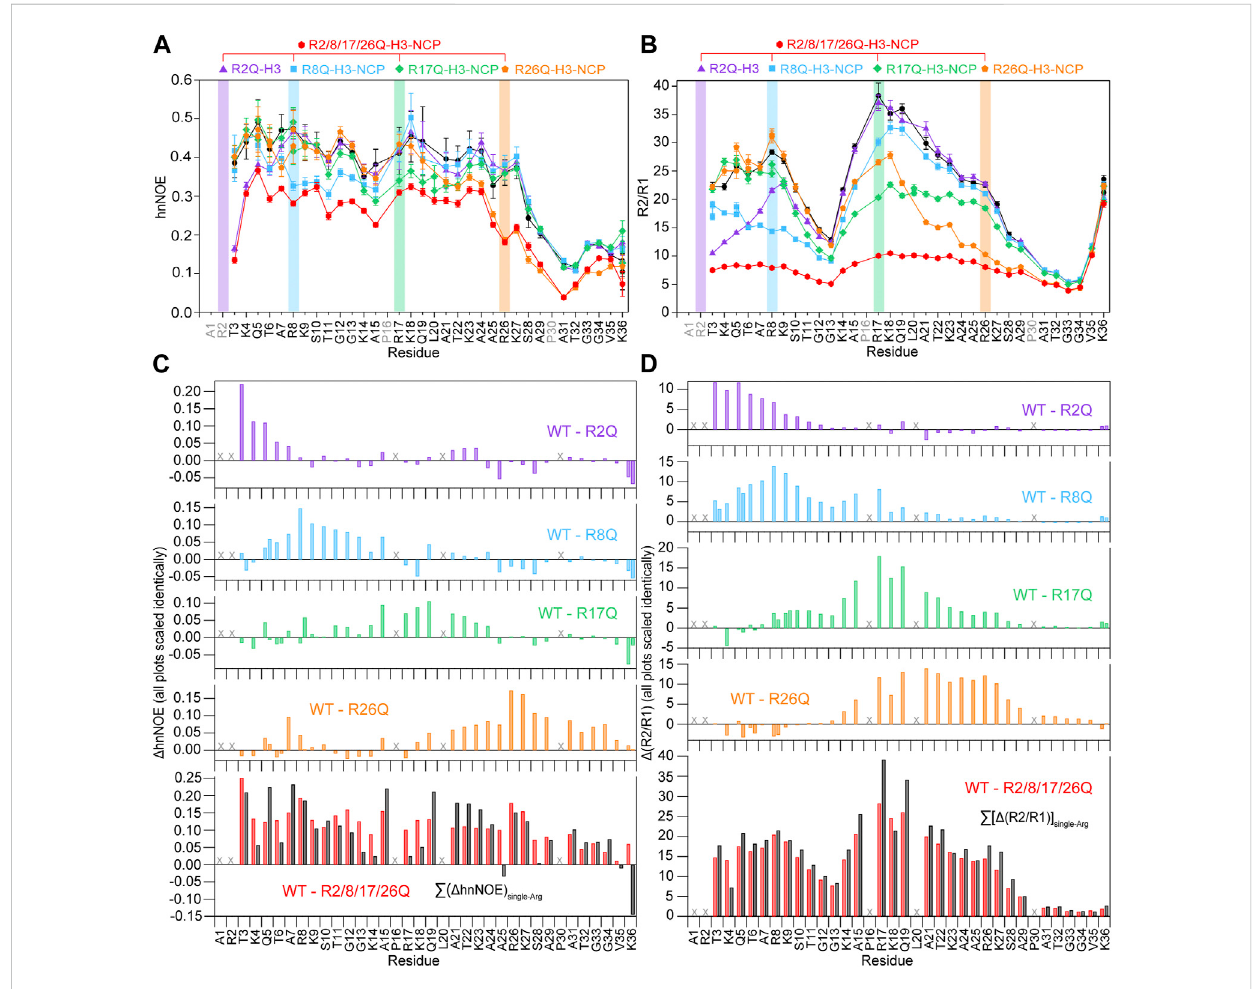
FIGURE 3 Neutralizing H3 tail arginines leads to a regional increase in H3 tail dynamics at 0 mM KCl. Plots are shown for (A) hnNOE values and (B) R2/R1 as a function of residue for WT- (black circles), R2Q- (purple triangles), R8Q- (blue squares), R17Q- (green diamonds), R26Q- (orange pentagons), and R2/8/ 17/26Q-H3-NCP (red hexagons). Error bars represent standard error propagation of the spectral noise for hnNOE values and were determined via the covariance matrix in fi tting R1 and R2 decay curves, which was subsequently propagated for R2/R1. Note that some error bars are smaller than the symbols. Difference plots for (C) hnNOE and (D) R2/R1 show the difference between the per-residue hnNOE or R2/R1 for the H3 tail within 15 N-WT-H3- NCP and within each single-arginine mutant (top four plots). The bottom plots show the difference between WT- and R2/8/17/26Q-H3-NCP (red) and the sum of the four difference plots for each single-arginine mutant (i.e., Δ hnNOE WT-R2Q + Δ hnNOE WT-R8Q + Δ hnNOE WT-R17Q + Δ hnNOE WT-R26Q on the lower left and Δ (R2/R1) WT-R2Q + Δ (R2/R1) WT-R8Q + Δ (R2/R1) WT-R17Q + Δ (R2/R1) WT-R26Q on the lower right) (black). “ X ” symbols mark residuesomitted from analysis. Two values are plotted for doublet peaks (see Section 2). Data were collected at 0 mM KCl, 800 MHz, and 304